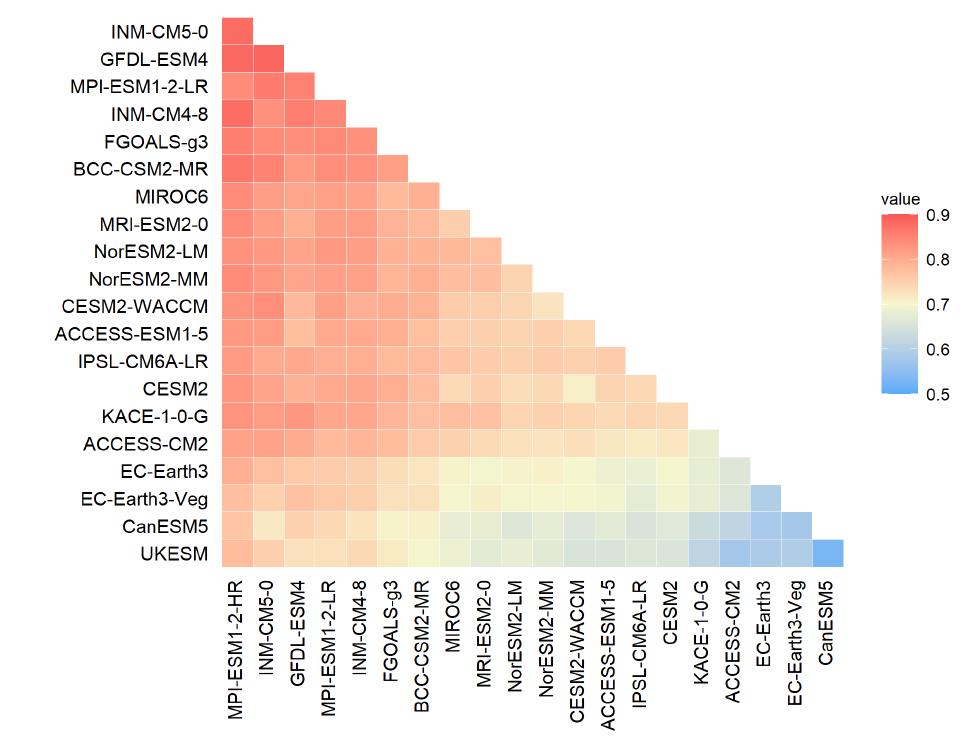
Figure 4. A graphical representation of the intermodel distance matrix for the 21 Coupled Model Inter-Comparison Project Phase 6 (CMIP6) models obtained from the five climate variables for East Asia. Each box represents a pairwise combination, where red colors indicate a greater independence and blue colors indicate a greater similarity.